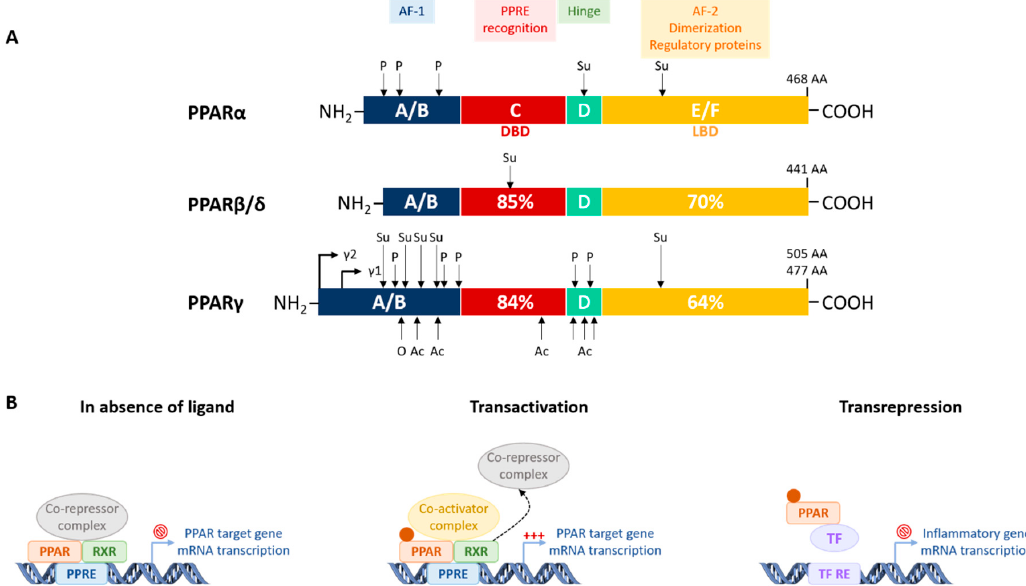
Figure 3. Protein structure and mechanisms of transcriptional regulation of PPARs. ( A ) Functional domains and posttranslational modifications of human PPARs. PPARs contain four distinct domains: a N -terminal A/B domain (ligand-independent AF-1), a C-domain (DNA-binding domain), a D- domain (hinge domain), and a C -terminal E/F domain (ligand-binding domain). Main functions of the 4 domains are listed. The number inside each domain corresponds to the percentage of amino acid sequence identity of human PPAR β / δ and γ relative to PPAR α . The number of amino acids indicated at the COOH-terminus are for the human receptors. The locations of posttranslational modification sites are indicated by arrows. The 2 splice variants of PPAR γ are indicated by γ 1 and γ 2. ( B ) PPAR mechanism of action. In the absence of ligand, PPAR-RXR heterodimers are bound to corepressor complexes and prevent gene transcription. Binding of an endogenous ligand or a synthetic agonist to the PPAR LBD triggers a conformational change, leading to corepressor complex dissociation and recruitment of coactivator complex. The activated PPAR/RXR heterodimer then binds to a specific DNA sequence in the promotor region of target genes (PPRE) and stimulates target gene transcription (transactivation). Through the binding to inflammatory transcription factors such as NF- κ B and AP-1 (identified by TF), PPARs inhibit their binding to DNA and negatively regulate expression of proinflammatory genes (transrepression). Abbreviations: AF-1, activation function-1; AF-2, activation function-2; PPRE, peroxisome proliferator response element; DBD, DNA binding domain; LBD, ligand binding domain; AA, amino acid; P, phosphorylation; Su, SUMOylation; Ac, acetylation; O, O -GlcNacylation; RXR, 9- cis retinoic acid receptor; TF, transcription factor; TF RE, transcription factor response element; NH 2 , protein N terminus; COOH, protein carboxyl terminus.